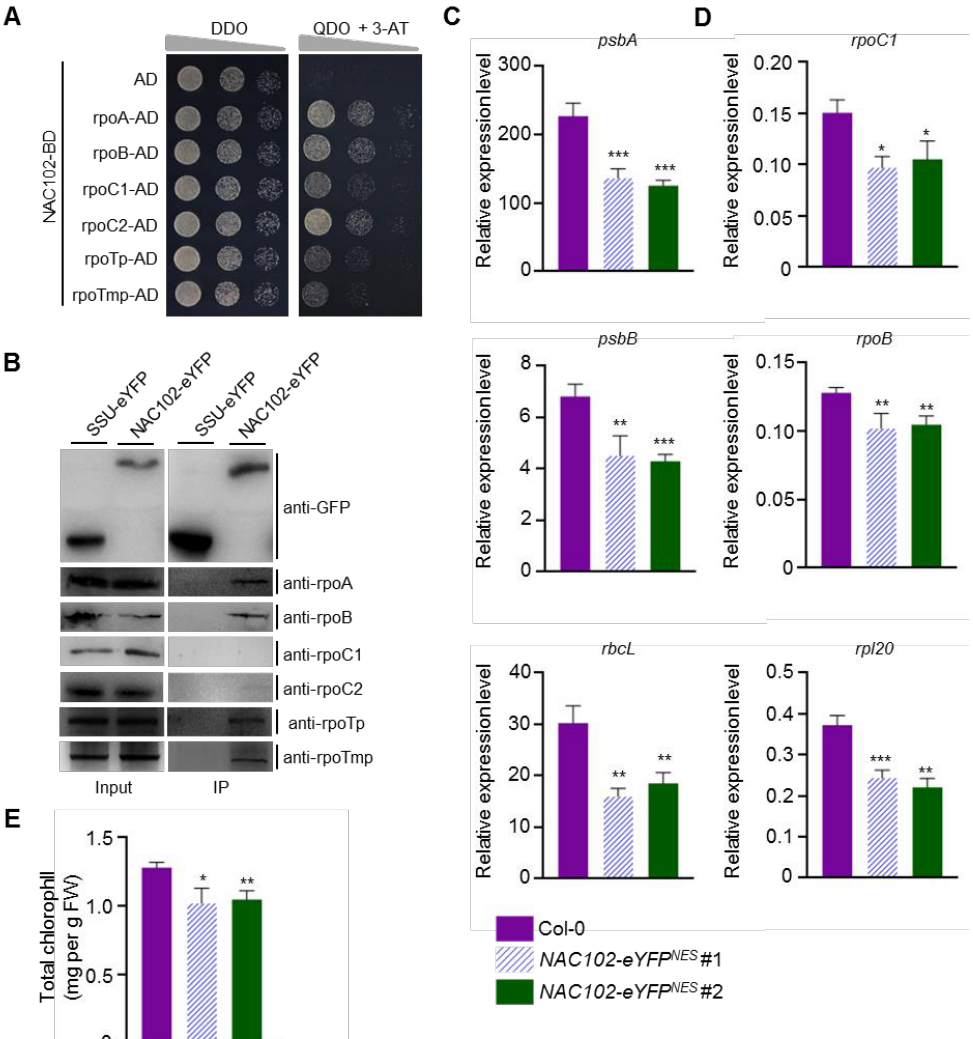
Figure 5. NAC102 interacts with chloroplast RNA polymerases to represses the expression of chloroplast genes. ( A ) Y2H assays. The serially diluted diploid cells were plated on DDO (lacking Trp and Leu) and QDO (lacking Trp, Leu, His, and Ade) supplemented with 10 mM 3-AT. The yeast growth on QDO + 3-AT indicates interaction. AD, activation domain. BD, DNA-binding domain. ( B ) CoIP assays. The total proteins of the NAC102-eYFP and SSU-eYFP transgenic lines were immunoprecipitated by GFP-Trap, followed by Western blotting using antibodies against rpoA, rpoB, rpoC1, rpoC2, rpoTp, and rpoTmp. The CoIP assays were repeated twice with similar results. ( C , D ) The relative expression level of the chloroplast genes determined by qRT-PCR analysis using EF1 α as the normalizer. ( C ) The PEP-dependent genes. ( D ) The NEP-dependent genes. ( E ) Total chlorophyll content in the indicated plants. The 3rd and 4th leaves were used. Data represent mean ± SD (n = 3). The statistical significances were determined using Student’s t -test (* p < 0.05, ** p < 0.01, and *** p < 0.001).